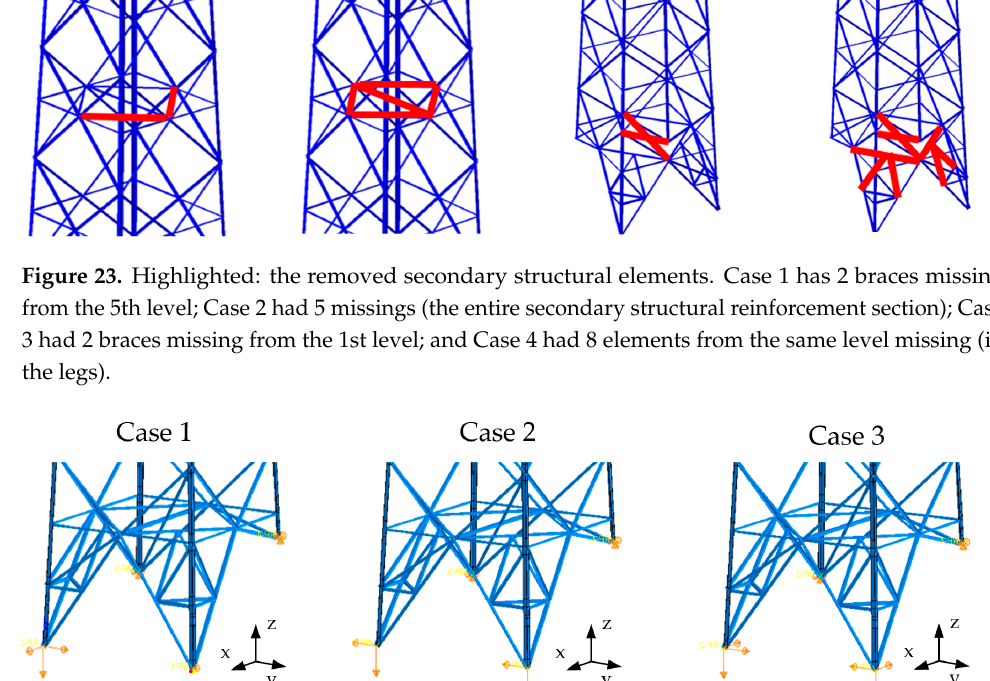
Table 7. Ultimate load capacity in LBA and RIKS analysis procedures, based on imperfections from Figures 22–24. Note that the reference design load case from SIA 261/1 is equivalent to a total load of 237.2 kN.